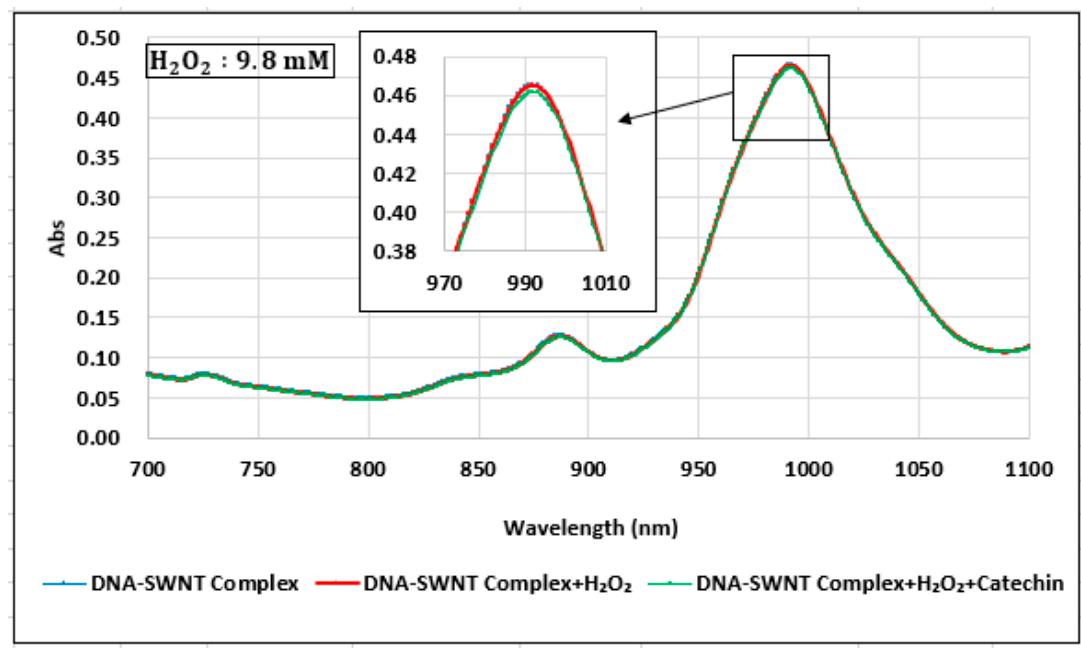
Figure 2. Absorption spectra of the DNA-SWNT complex following the addition of H 2 O 2 and catechin. H 2 O 2 did not significantly change the spectra.